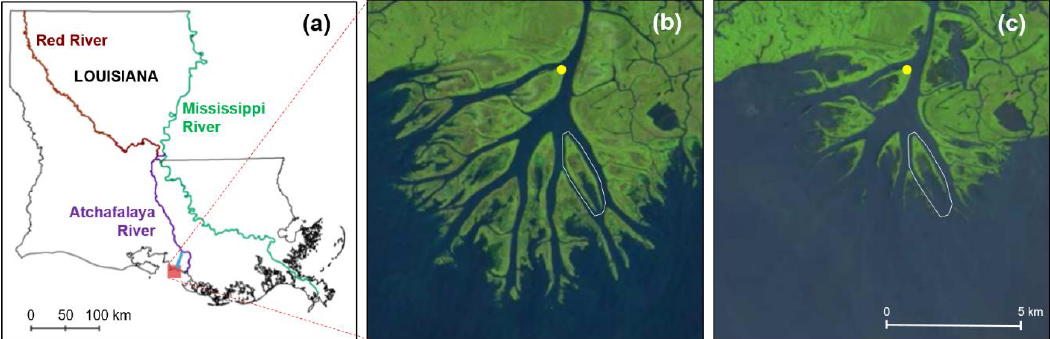
Figure 1. Study area. ( a ) The Wax Lake Delta (WLD, red square) is located at the terminus of the Wax Lake Outlet (blue line), which diverts water from the Atchafalaya River (purple line) in the U.S. state of Louisiana. The Atchafalaya is a distributary channel for the Mississippi (green line) and Red (red line) Rivers. ( b ) Image of WLD from 28-Sep-2010 by Landsat [88], for water level y = 0.35 m (NAVD88) at Camp Island gage (yellow dot) [93]. ( c ) Image of WLD from 24-Apr-2011 by Landsat [88], for water level y = 0.67 m (NAVD88) at Camp Island gage. WLD Pintail Island test case area outlined in white.